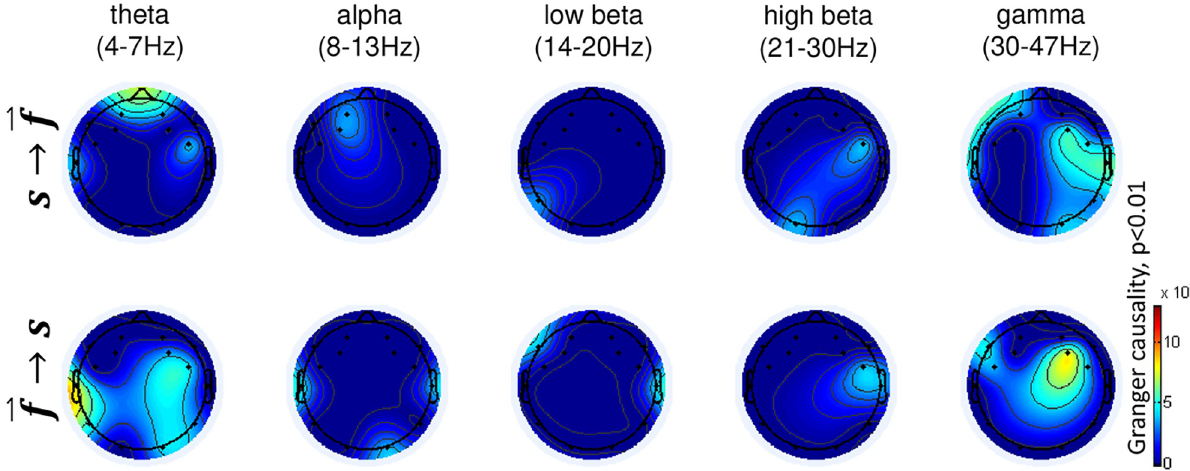
Fig 8. Granger-causal information flows during task ! happy in session S02 jointly computed for P01, P04, P05 (participants with good modulation performance). s ! ~ f indicates causal flow from feedback to brain activity features (top row) and ~ f ! s from brain activity features to feedback (bottom row). The g-causalities are statistically tested for significance ( p < 0.01) and Bonferroni-corrected.